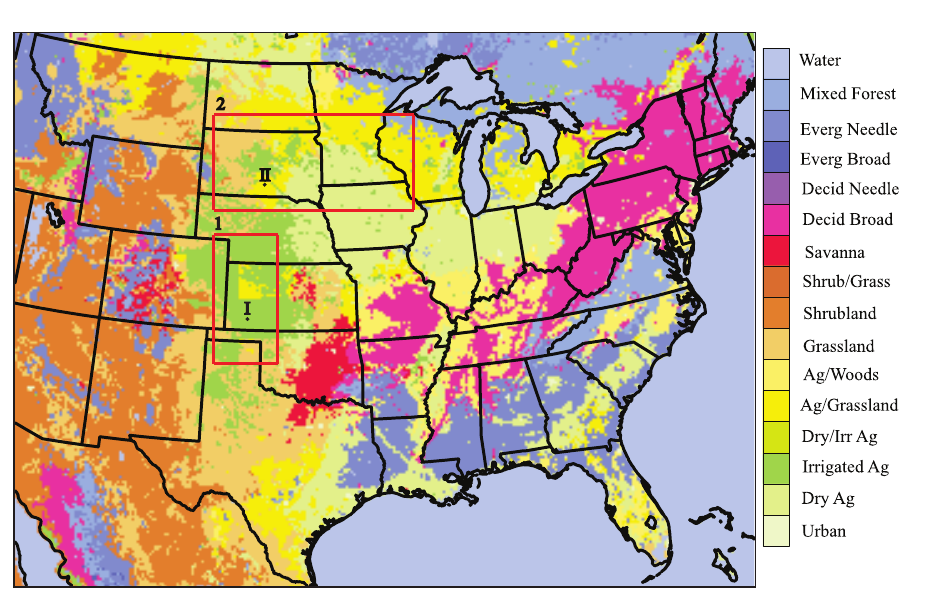
Figure 1. Land cover classification employed for all model cases, plotted over the entire WRF model domain. Regions labeled 1 and 2 are analysis domains that represent the irrigated and 850-mb downstream regions discussed in Section 3. Areas of regions 1 and 2 are 180,000 and 460,800 km 2 , respectively. Points labeled I and II represent locations of thermodynamic profiles explored in Section